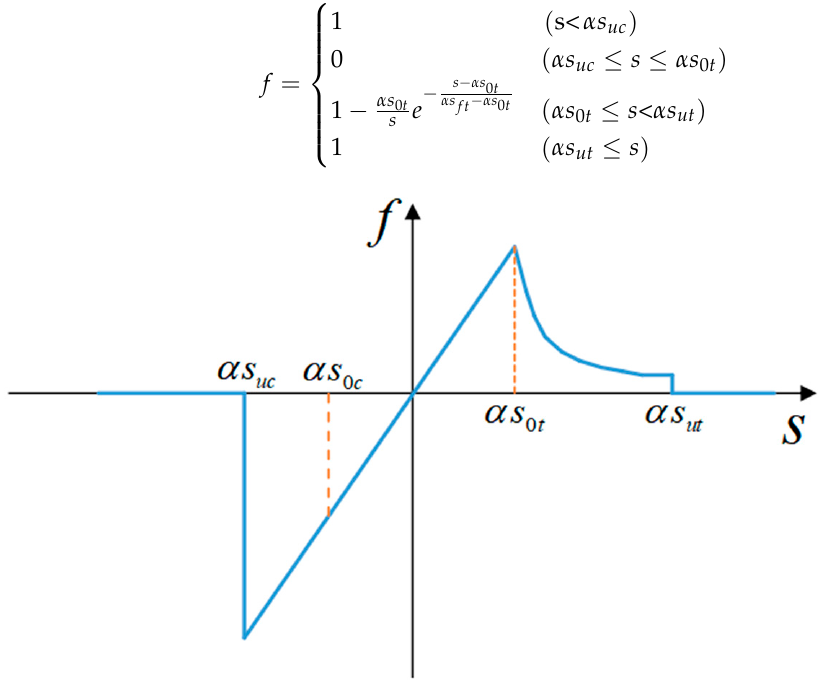
Figure 3. Adhesion-tension relationship for concrete material